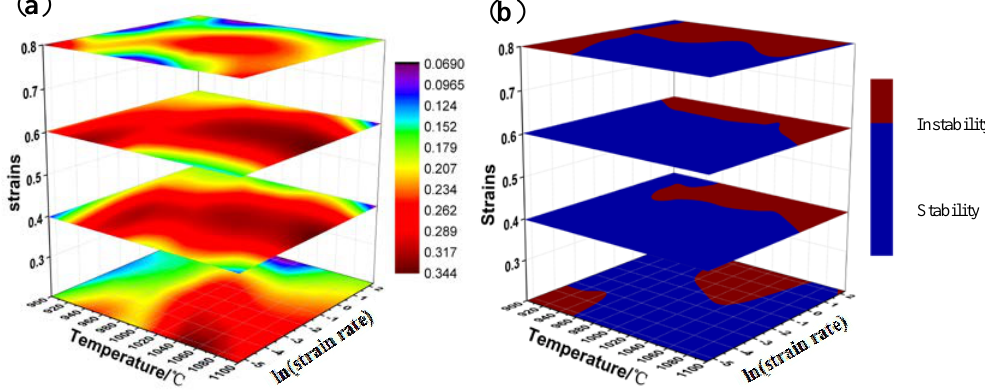
Figure 11. Three-D distribution maps of ( a ) power dissipation efficiency and ( b ) instability parameter under different conditions.